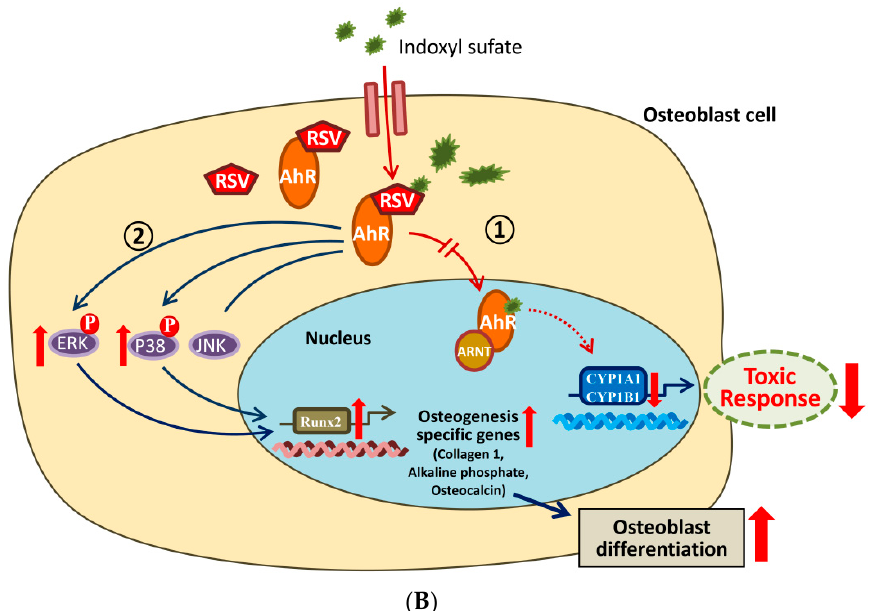
Figure 7. AhR downstream pathway in the cytoplasm. ( A ) ① IS can activate the classic function of AhR, increasing the expression of target proteins such as CYP1A1 and CYP1B1. ② IS can inhibit the phosphorylation of ERK and p38 MAPK through the AhR pathway in the cytoplasm. The binding of IS to AhR initiates a cytoplasmic signaling pathway that inhibits the phosphorylation of ERK and p38 MAPK, which then reduces the expression of Runx2 to impede osteoblast differentiation. ( B ) ① RSV, an AhR antagonist, blocks the activation of AhR and then diminishes the expression of CYP1A1 and CYP1B1. ② RSV can restore the reduction in ERK and p38 MAPK phosphorylation due to IS and then ameliorate the expression of Runx2 to promote osteoblast differentiation. P in red circle means phosphorylation of the substance. Upward red arrow indicates increase. Downward red arrow indicates decrease. Dotted blue or red arrow indicates weakened.